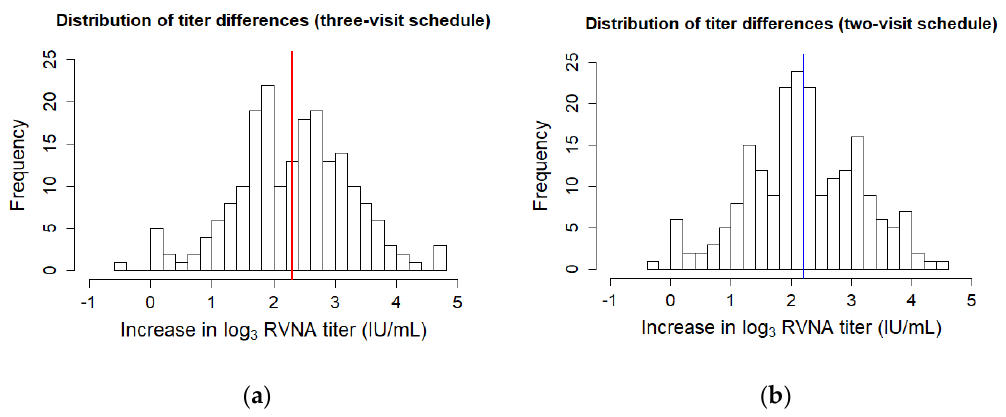
* For the log 3 values, this row displays the additive difference between post-booster and pre-booster titers. For the non-log-transformed values, this row displays the multiplicative difference (fold increase) between post-booster and pre-booster titers.